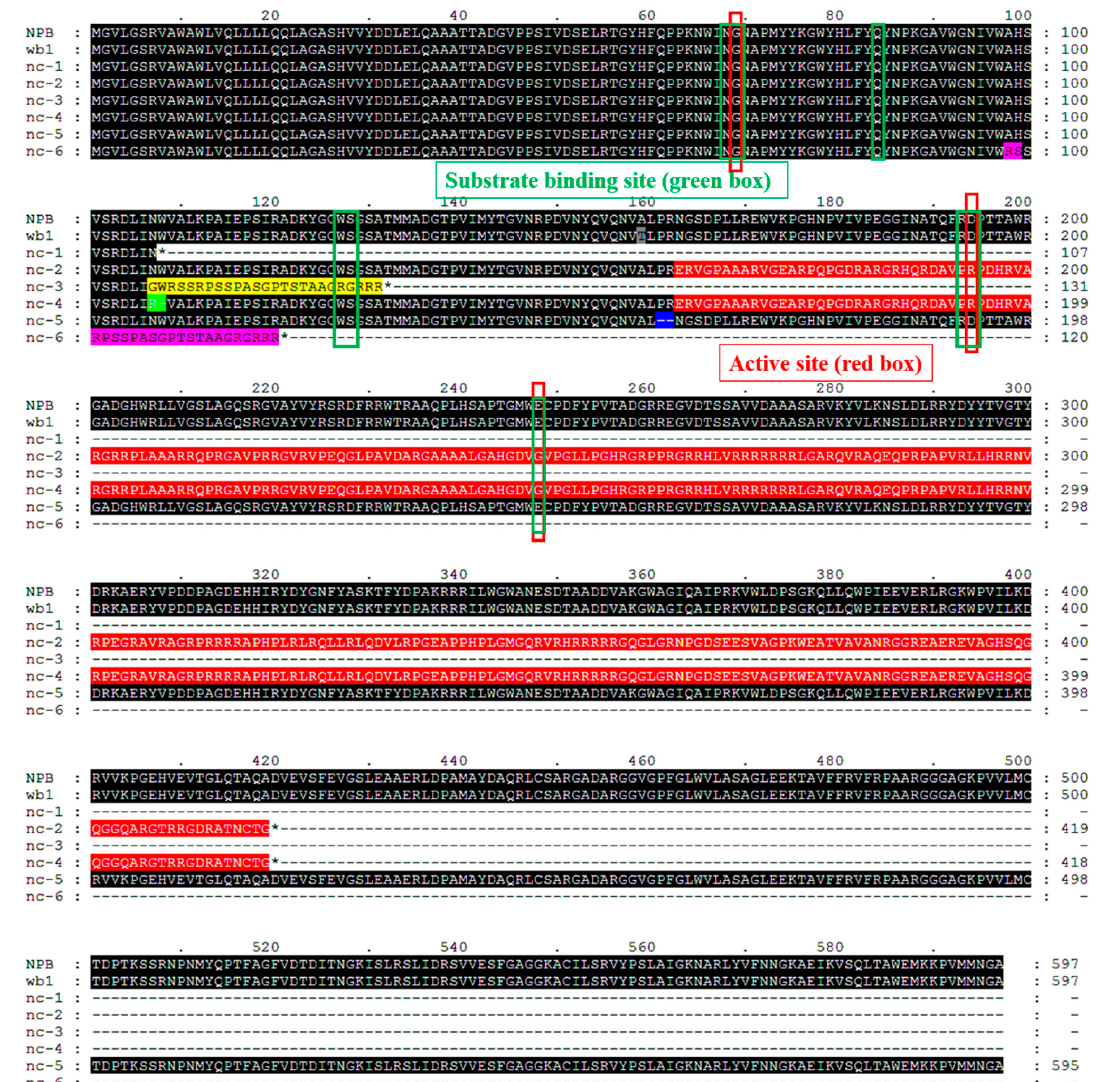
Figure 7. WB1 alignments of NPB (WT) with six mutant lines and wb1 . Analysis performed with MEGA 5.0 software. The substrate binding site (eight residues, green boxes) and the active site (three residues, red boxes) are indicated by the Blast search program (http://www.ncbi.nlm.nih.gov/BLAST/). Black color indicates a sequence that is consistent with that of WT. Except for the black color, the same color represents the same sequence, and different colors represent the different mutations among the mutant lines.